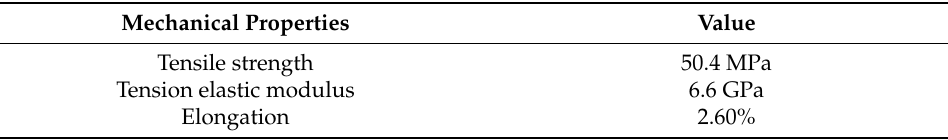
Table 5. Mechanical properties of the epoxy